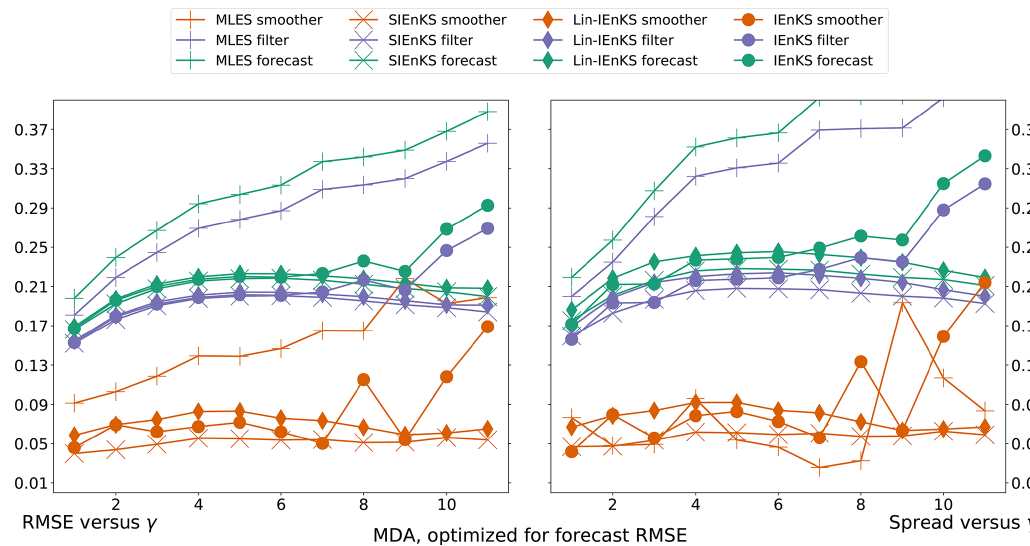
Figure 17. MDA configuration. RMSE and spread versus γ . Lag and inflation are optimized for a minimum forecast RMSE.